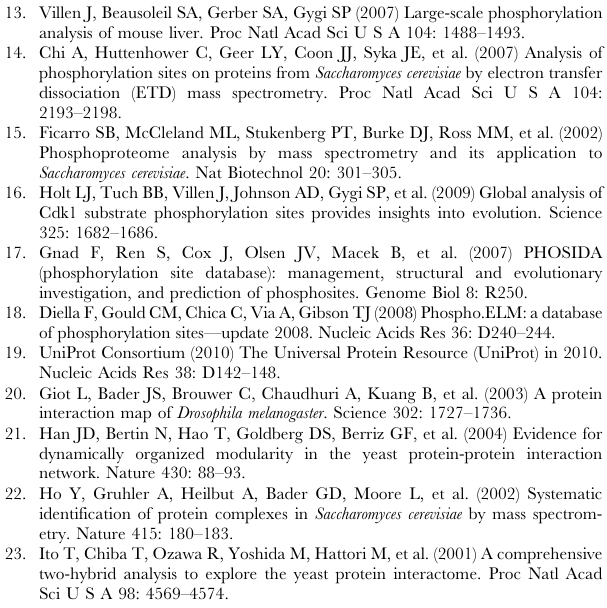
show proportions of proteins with more than the k interacting partners indicated on the horizontal axis [ P $ ( k )]. Figure S8 Number counts of interacting protein pairs of each phosphorylation pattern shown in the phospho-PPI networks of the ‘‘IMM’’ and ‘‘TAP’’ categories. See legend to Fig. 6 for details. Found at: doi:10.1371/journal.pcbi.1001064.s008 (0.60 MB TIF) Figure S9 Number counts of IKMs formed in the ‘‘filtered’’ PPI network by each of the kinases shown in Fig. 7. For each kinase, arrows indicate number counts of IKMs formed by that kinase and the ‘‘filtered’’ PPI network, with P values estimated by comparison with negative controls. See legend to Fig. 7 for details. Table S1 Phosphoproteome data used in this study. Table S2 List of known and predicted S. cerevisiae genes and phosphorylation annotation. Table S3 Phosphoproteome data used in this